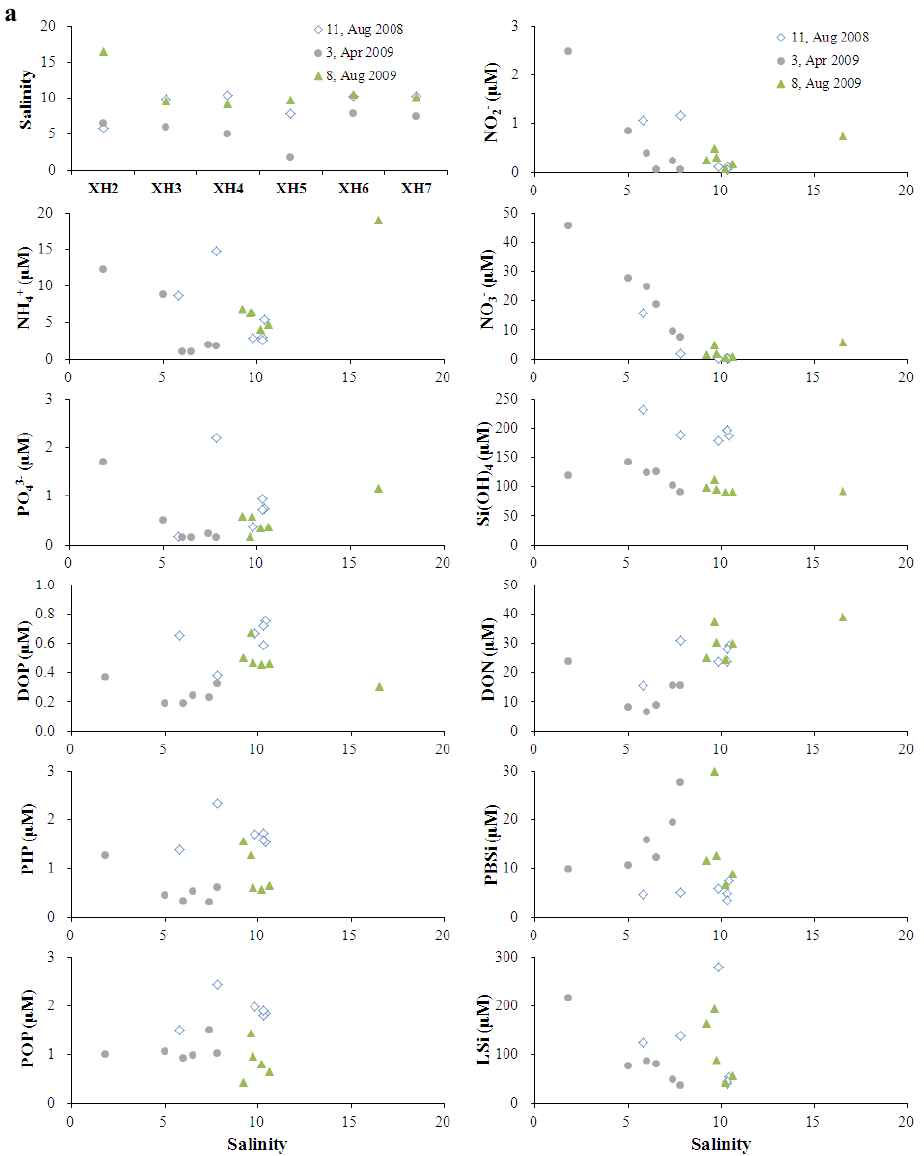
Figure 2 Spatial distributions of salinity and nutrients ( μ M) as a function of salinity in surface water of Xiaohai (a) and Laoyehai (b) lagoons during the study period.